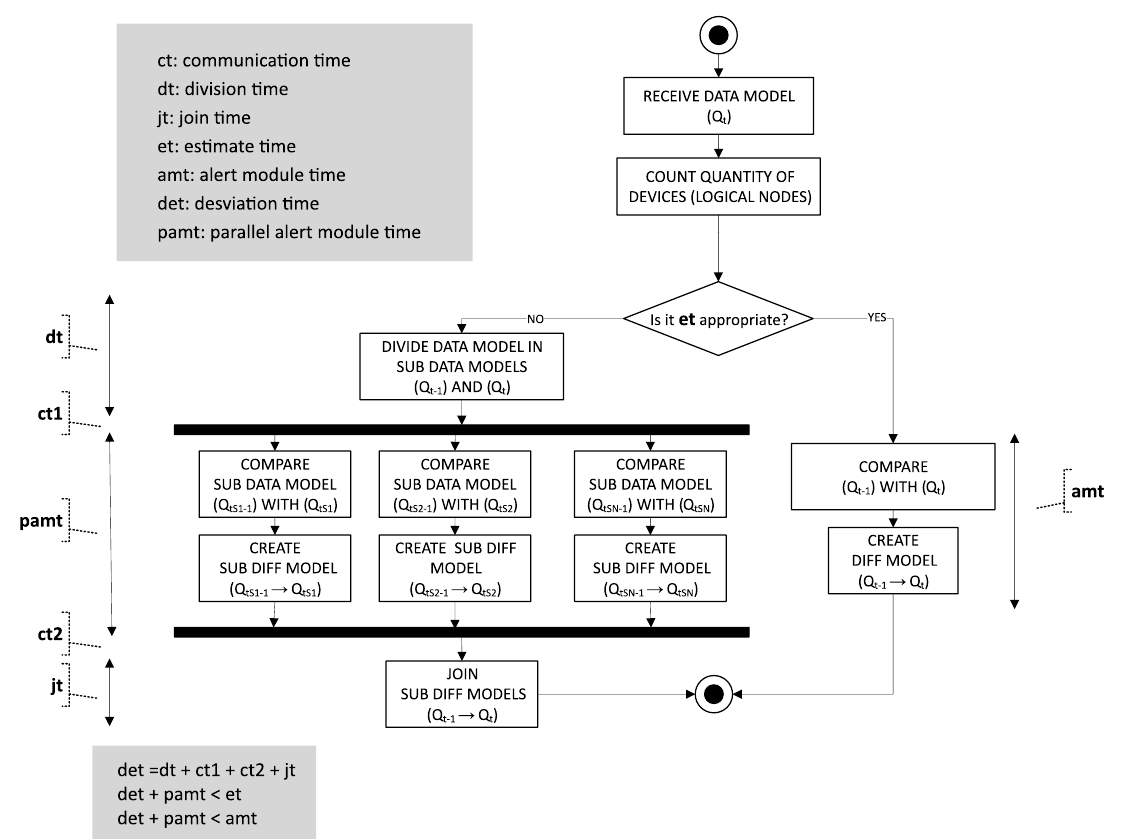
Figure 11. An activity diagram for reducing the alert module result